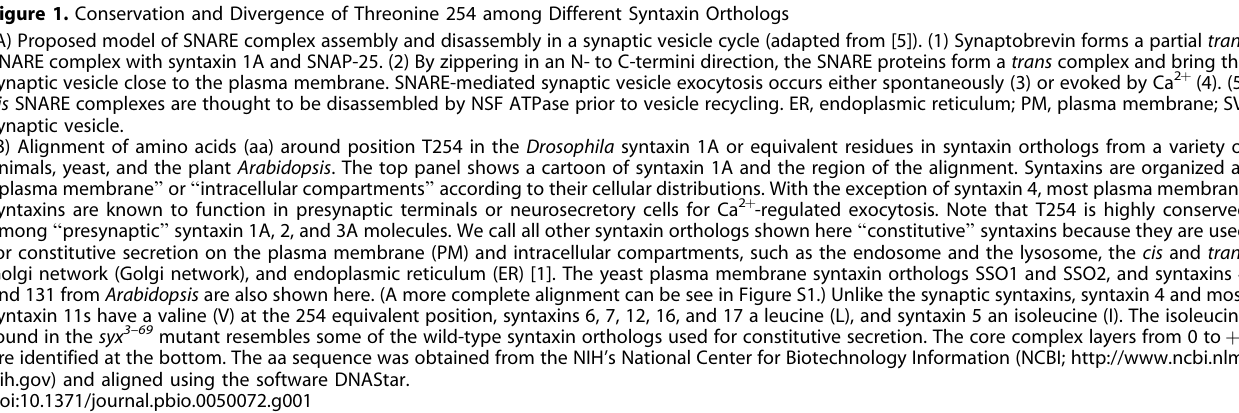
Figure 1. Conservation and Divergence of Threonine 254 among Different Syntaxin Orthologs (A) Proposed model of SNARE complex assembly and disassembly in a synaptic vesicle cycle (adapted from [5]). (1) Synaptobrevin forms a partial trans SNARE complex with syntaxin 1A and SNAP-25. (2) By zippering in an N- to C-termini direction, the SNARE proteins form a trans complex and bring the synaptic vesicle close to the plasma membrane. SNARE-mediated synaptic vesicle exocytosis occurs either spontaneously (3) or evoked by Ca 2 þ (4). (5) cis SNARE complexes are thought to be disassembled by NSF ATPase prior to vesicle recycling. ER, endoplasmic reticulum; PM, plasma membrane; SV, synaptic vesicle. (B) Alignment of amino acids (aa) around position T254 in the Drosophila syntaxin 1A or equivalent residues in syntaxin orthologs from a variety of animals, yeast, and the plant Arabidopsis . The top panel shows a cartoon of syntaxin 1A and the region of the alignment. Syntaxins are organized as ‘‘ plasma membrane ’’ or ‘‘ intracellular compartments ’’ according to their cellular distributions. With the exception of syntaxin 4, most plasma membrane syntaxins are known to function in presynaptic terminals or neurosecretory cells for Ca 2 þ -regulated exocytosis. Note that T254 is highly conserved among ‘‘ presynaptic ’’ syntaxin 1A, 2, and 3A molecules. We call all other syntaxin orthologs shown here ‘‘ constitutive ’’ syntaxins because they are used for constitutive secretion on the plasma membrane (PM) and intracellular compartments, such as the endosome and the lysosome, the cis and trans Golgi network (Golgi network), and endoplasmic reticulum (ER) [1]. The yeast plasma membrane syntaxin orthologs SSO1 and SSO2, and syntaxins 4 and 131 from Arabidopsis are also shown here. (A more complete alignment can be see in Figure S1.) Unlike the synaptic syntaxins, syntaxin 4 and most syntaxin 11s have a valine (V) at the 254 equivalent position, syntaxins 6, 7, 12, 16, and 17 a leucine (L), and syntaxin 5 an isoleucine (I). The isoleucine found in the syx 3–69 mutant resembles some of the wild-type syntaxin orthologs used for constitutive secretion. The core complex layers from 0 to þ 8 are identified at the bottom. The aa sequence was obtained from the NIH’s National Center for Biotechnology Information (NCBI; http://www.ncbi.nlm. nih.gov) and aligned using the software